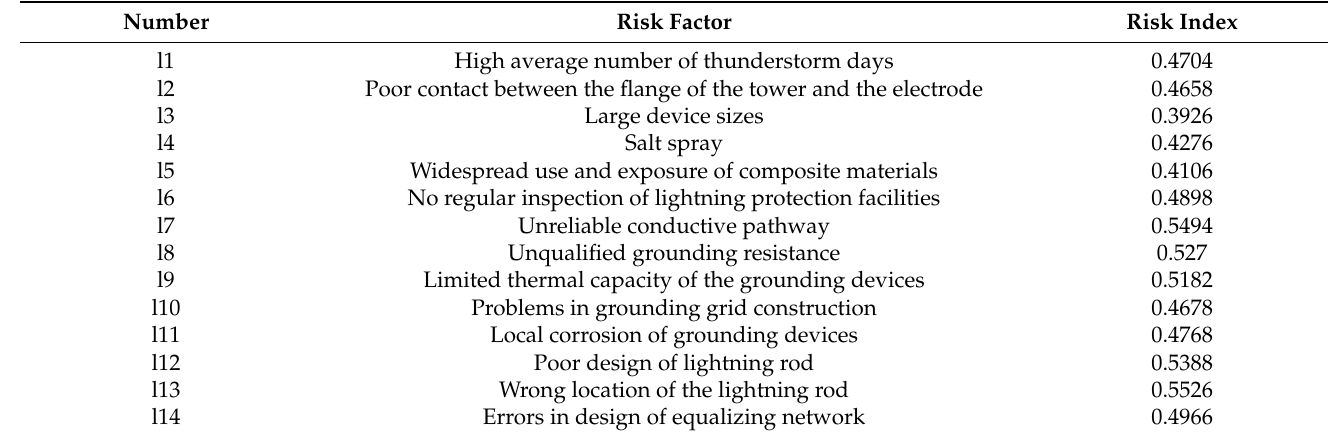
Table 4. Lightning strike risk factors of offshore wind farms.